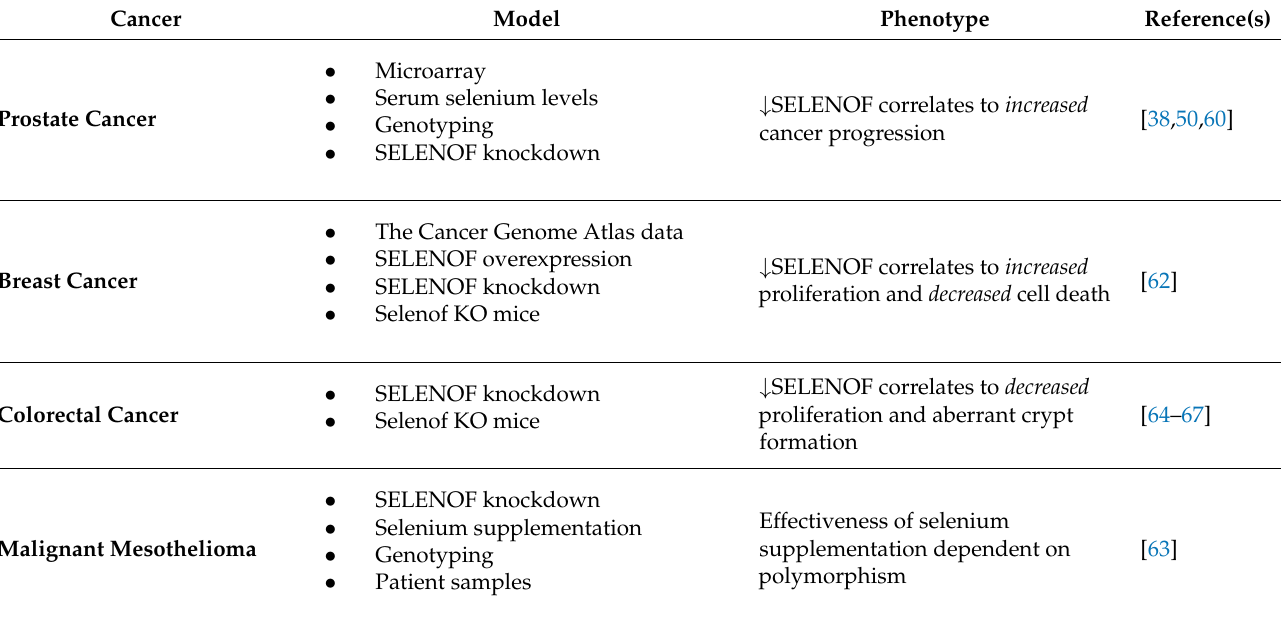
Table 1. A summary table of the impact on SELENOF in various cancers is